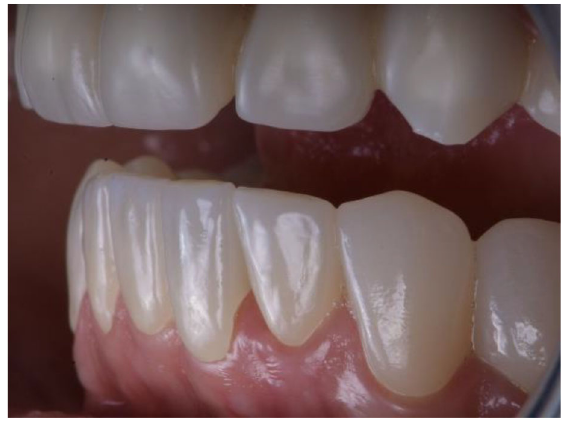
Figure 20. Lower zirconia crowns, upper PMMA during the try-in